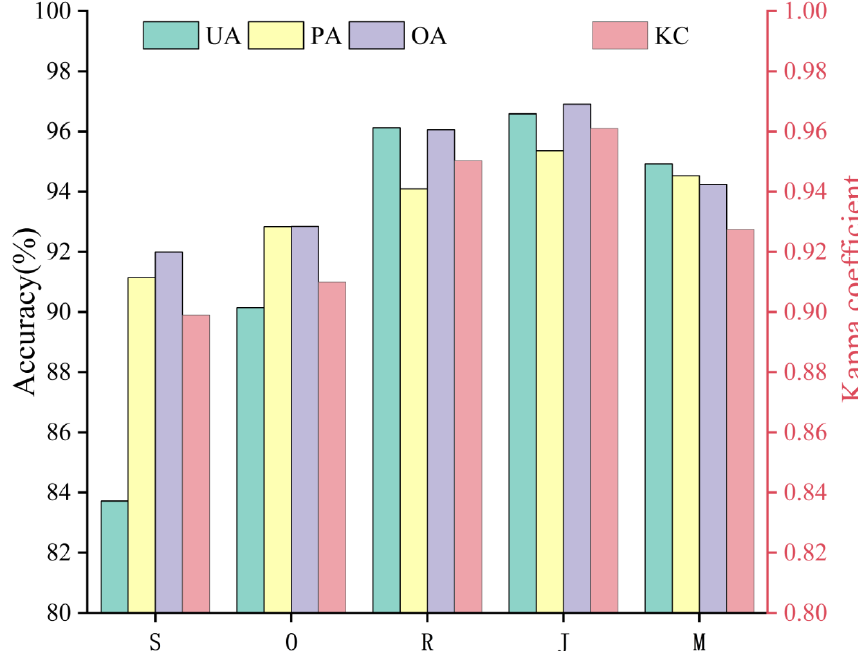
Figure 2. Results for the accuracy achieved using the random forest algorithm. S, O, R, J and M stand for the seeding-tillering, overwintering, reviving, joining-heading and flowering-maturing periods, respectively. The user accuracy (UA) (blue), producer accuracy (PA) (yellow) and overall accuracy (OA) (purple) are plotted on the left-hand vertical axis. The kappa coefficient (pink) is plotted on the right-hand vertical axis.